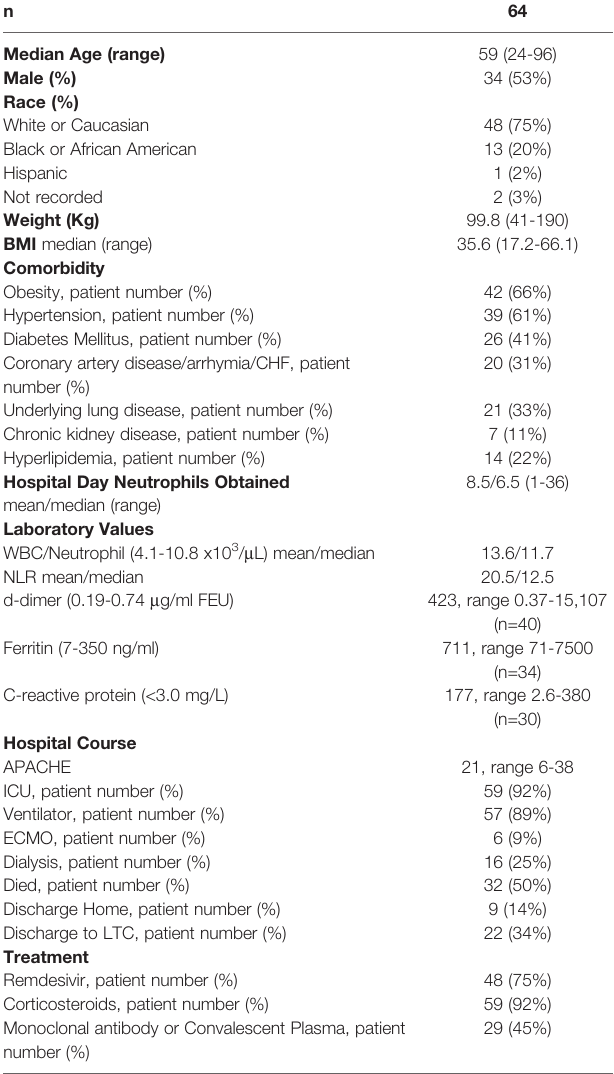
TABLE 1 | Clinical characteristics and